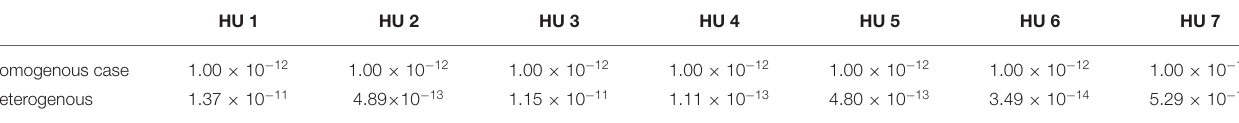
TABLE 2 | Conductance coefficients (in m) of riverbed